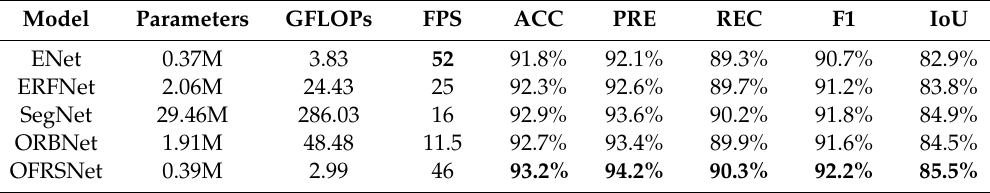
Table 2. Evaluation results of models trained with spatially-weighted cross-entropy loss (CE-SW).